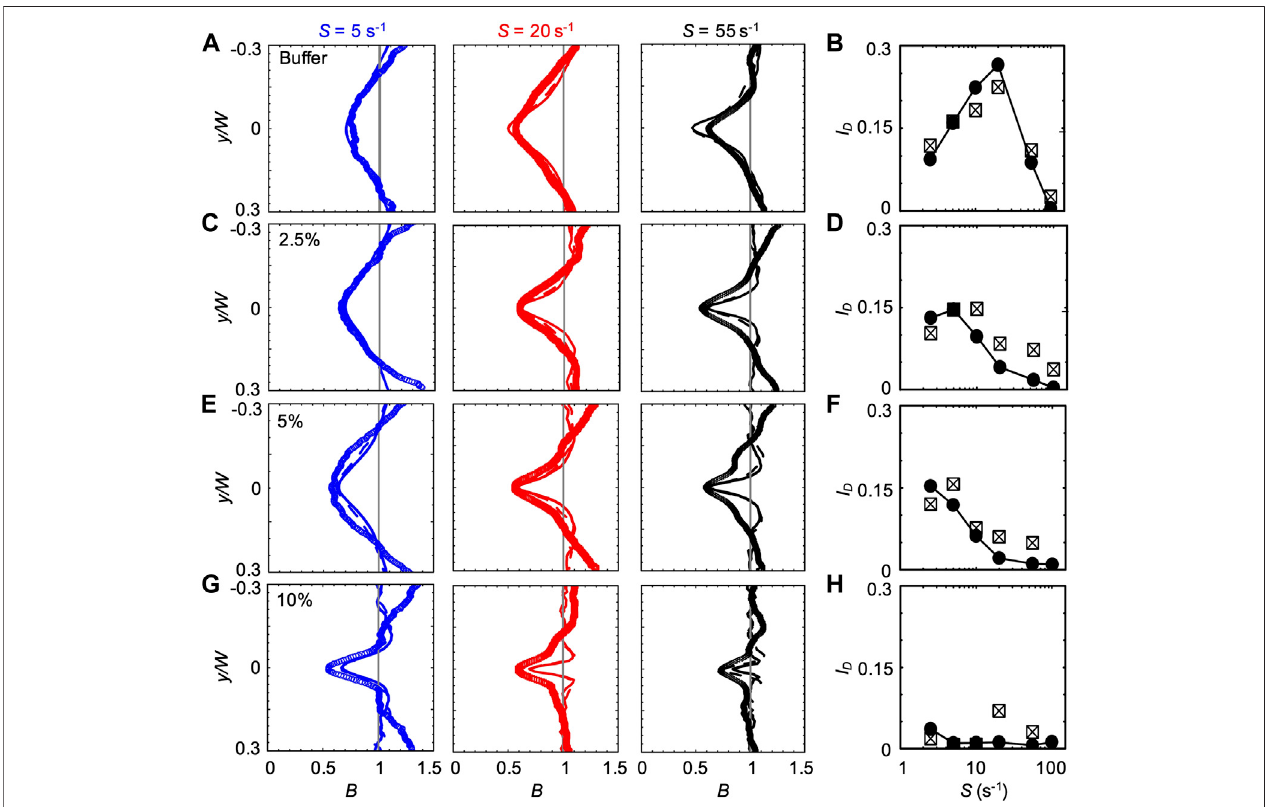
FIGURE 3 | (A,C,E,G) Bacterial concentration pro fi les B of P. aeruginosa obtained from the experiments (symbols) and from the mathematical model (lines) for mean shear rates S = 5 s − 1 (blue), S = 20 s − 1 (red), and S = 55 s − 1 (black) in buffer (A) and in PVP 360 solutions at 2.5 w/v % (C) , 5 w/v % (E) and 10 w/v % (G) . All the pro fi les were measured or computed at a distance D = 50 cm from the inlet and normalized by the mean bacterial concentration in the no- fl ow case. The numerical concentration pro fi les were obtained by modelling bacterial transport in a straight 50 cm-long channel (continuous line) and in a 50 cm-long serpentine channel (dashedline). (B,D,F,H) Thedepletionindex I D asafunctionofthemeanshearrate S inbuffer (B) andinPVP360solutionsat2.5w/v% (D) ,5w/v% (F) and10w/v% (H) . The reported values were calculated for both the experimental (squares) and numerical ( fi lled circles) bacterial concentration pro fi les. The numerical values were calculated from the pro fi les simulated in the straight 50 cm-long channel con fi